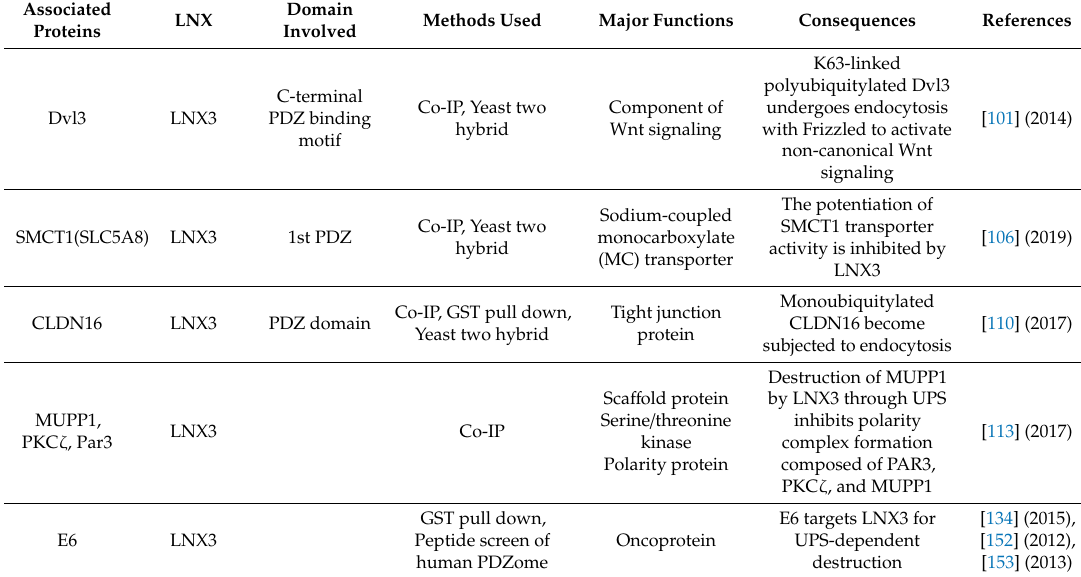
Table 3. LNX3 / PDZRN3 interacting